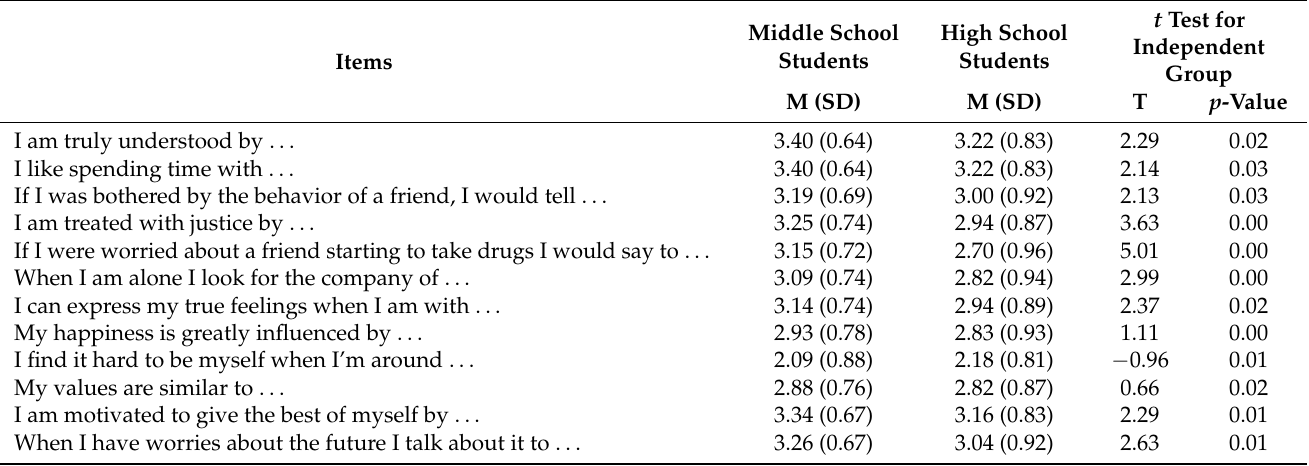
Table 6. The Independent Samples t Test: significant items of Mother Relationship Scale.